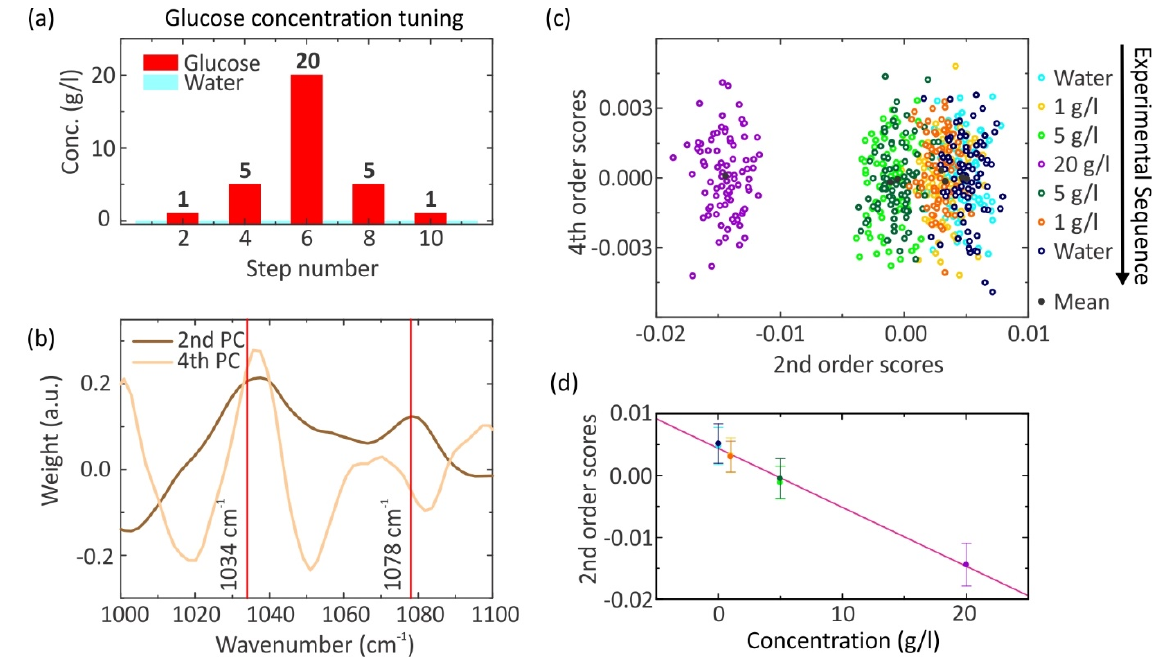
Figure 3. ( a ) Measurement cycle of very low concentration aqueous glucose solutions and water. The red bars indicate the glucose concentration of the solution; 85 spectra are taken for the aqueous glucose solutions as well as for water in the first and eleventh step. ( b ) The principal components of the 2nd (brown) and 4th (sandy brown) order are plotted against the wavenumber. The red lines indicate the vibrational modes of glucose at 1034 cm − 1 and 1078 cm − 1 . As can be seen from the spectral behavior, the 2nd PC contains vibrational information. ( c ) The 4th order scores are plotted against the 2nd order scores. The measurement cycle is depicted on the right and runs from top to bottom. All measurement steps are color-coded. The mean value of the 2nd order scores enables the concentration estimation of the aqueous glucose solution down to a concentration of c = 1 g/L. ( d ) Mean 2nd order scores as a function of glucose concentration, extracted from ( c ) demonstrating the linearity of the measurement. The color code matches the color code in ( c ). A linear fit is plotted in red. The error bar represents the standard deviation.